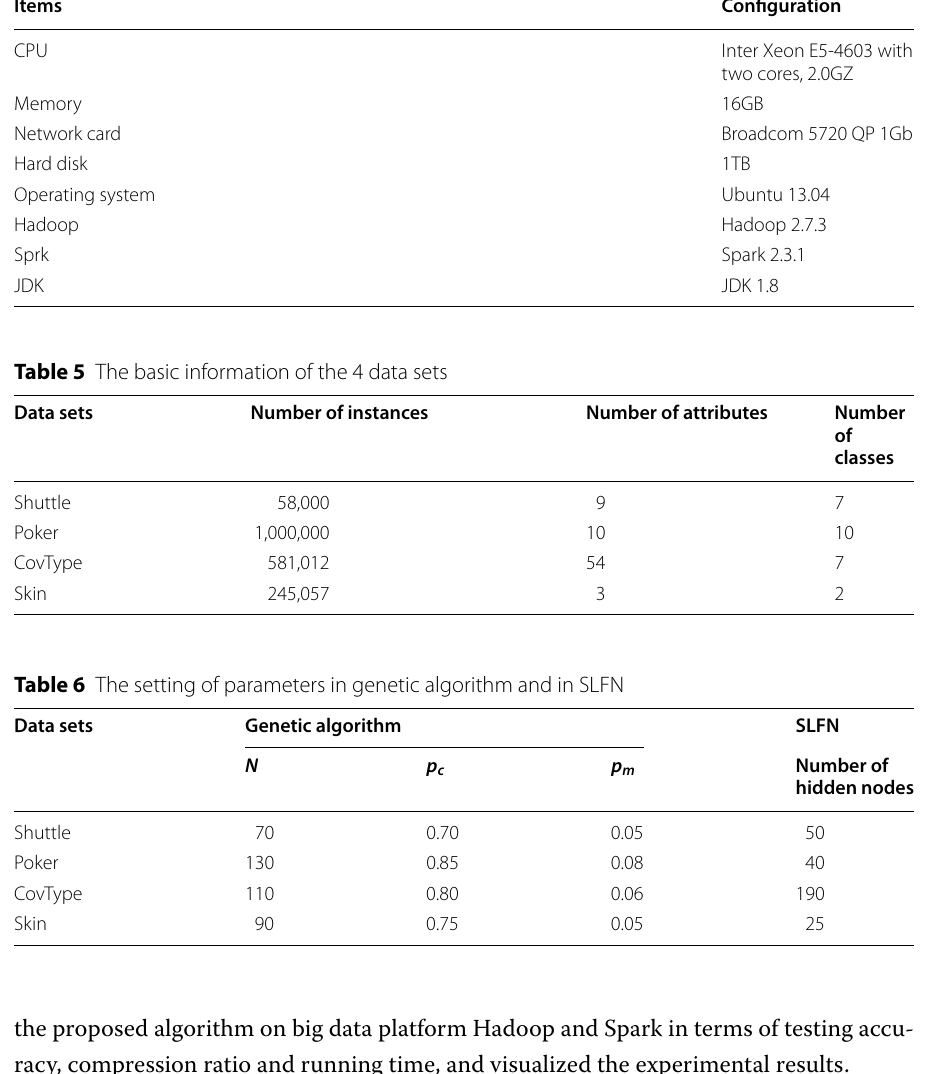
Table 4 The configuration of the nodes in the computing platform Items